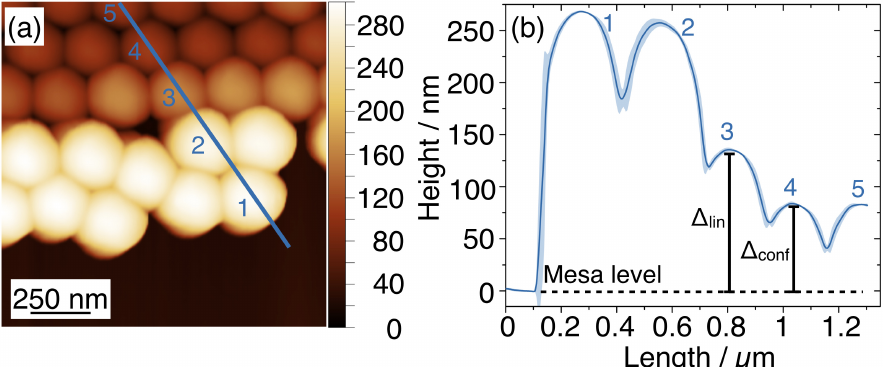
Figure 7. ( a ) AFM micrograph acquired on the NSs monolayer inside a linear template. The coloured line indicates the height profile evaluated on the topographic image. ( b ) The corresponding line graph presents the height variation as a function of lateral displacement. The value of the distance between NSs #3 and the top of the mesa is reported as ∆ lin = ( 136 ± 2 ) nm.